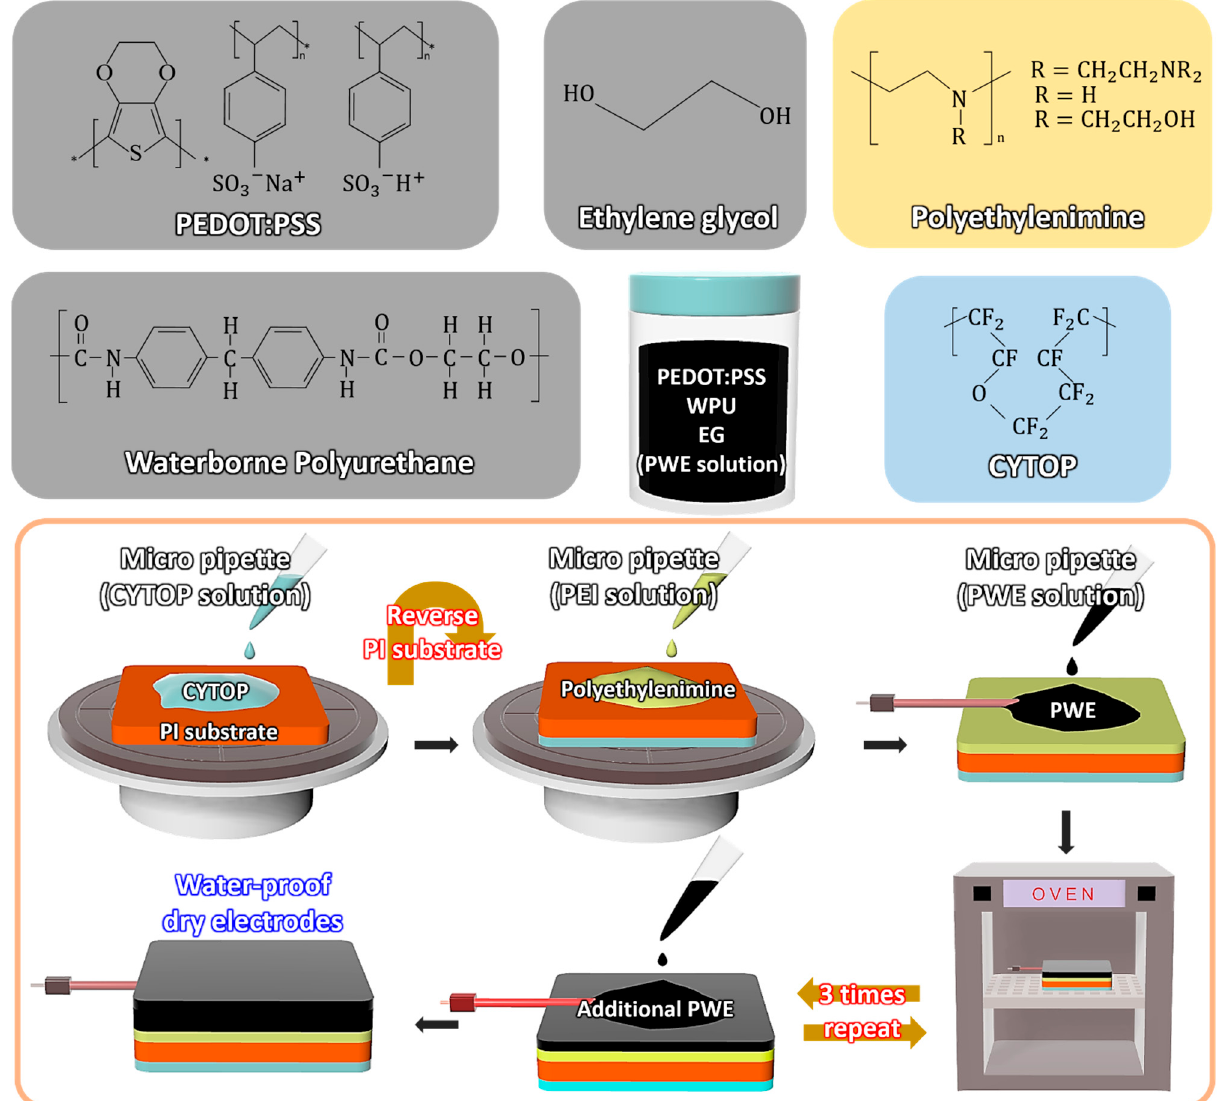
Figure 1. The 3D illustration of the waterproof dry-type PEDOT:PSS (WPD) electrode fabrication process and chemical structure of constituent materials.